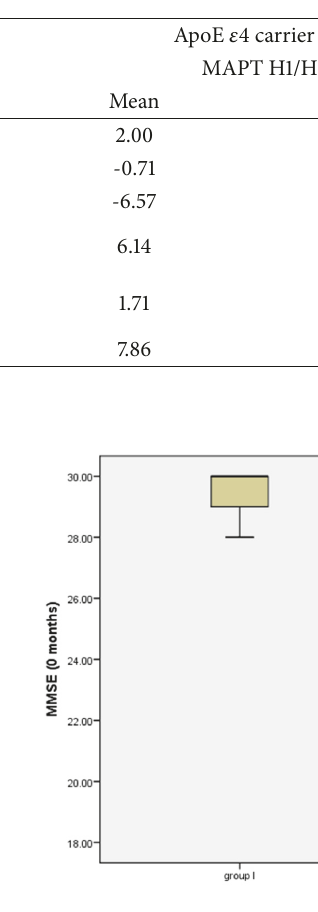
Table 4: The mean change in different assessment scales (between 0 and 3 months) of PD patients with different combination of genotypes in Group I and Group II patients.